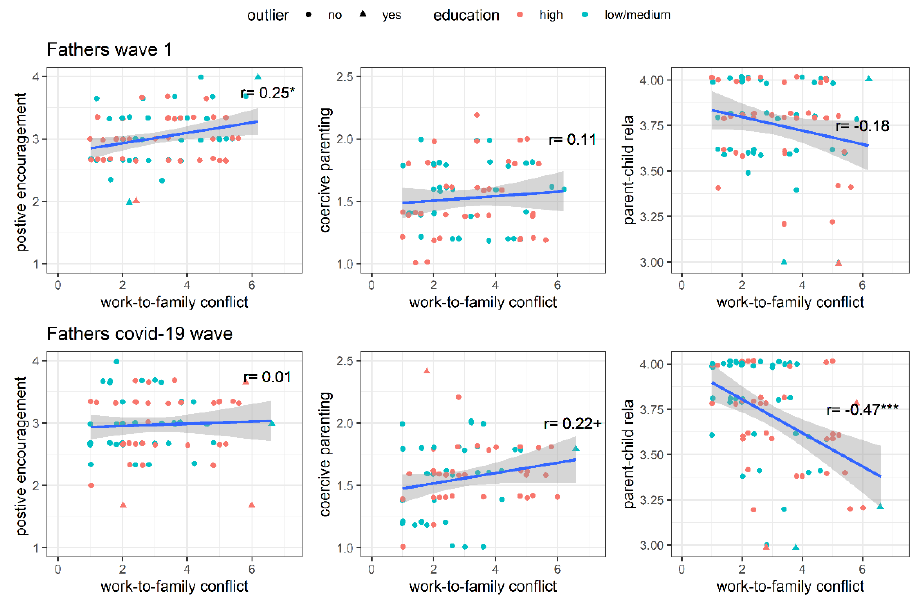
Figure A.4 W → F-conflict and perceived parenting for